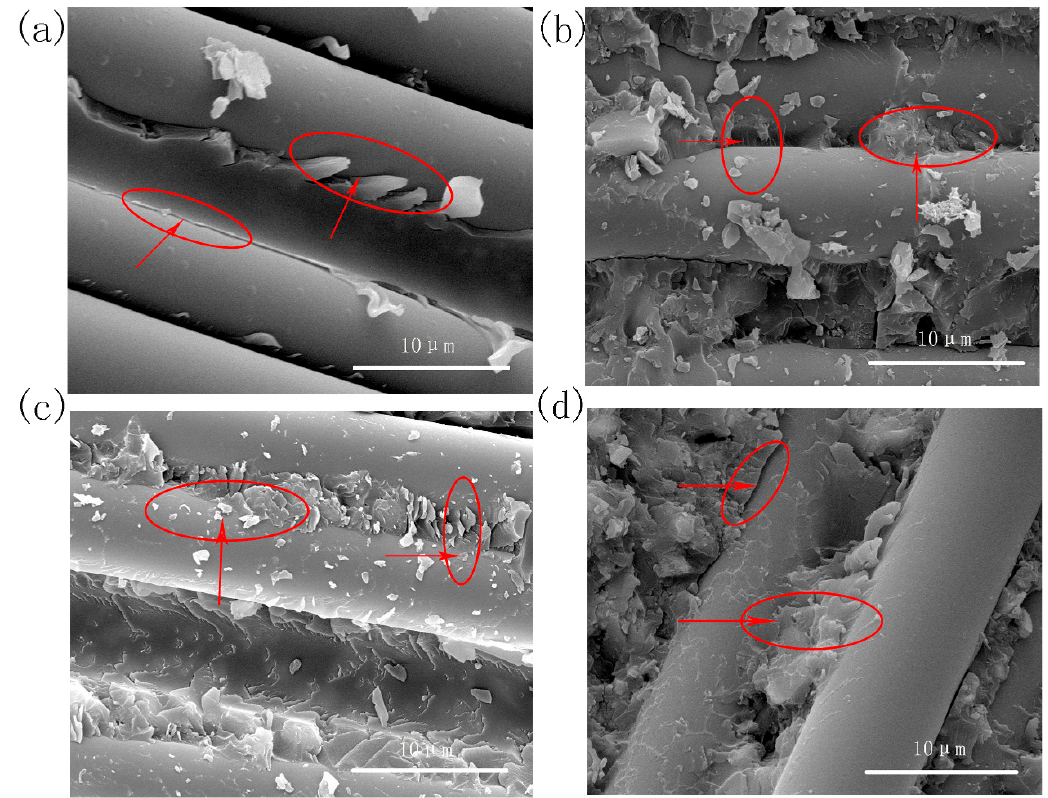
Figure 6. The morphology of the fracture surface for DABA-Ph/BMI/GF composite laminates with various content of BMI treated at 320 °C: ( a ) DABA-Ph; ( b ) DABA-Ph/BMI-1/2; ( c ) DABA-Ph/BMI-1/1 and ( d ) DABA-Ph/BMI-1/2.